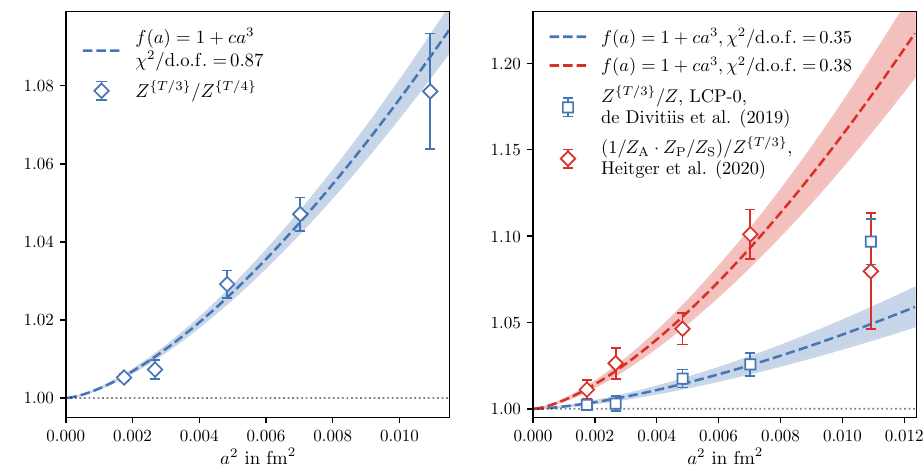
Table 7 Z values at the couplings used in CLS simulations, obtained from the interpolation formula (C.1a), excluding the coarsest lattice spacing from the fit. As explained in the text, an additional systematic error is added to the β = 3 . 85 and β = 3 . 4 results and the errors β Z = Z { T / 3 } interpolated, this work Z , LCP-0 de Divitiis et al. Z , LCP-1 de Divitiis et al. ∂ ln Z /∂ g 2